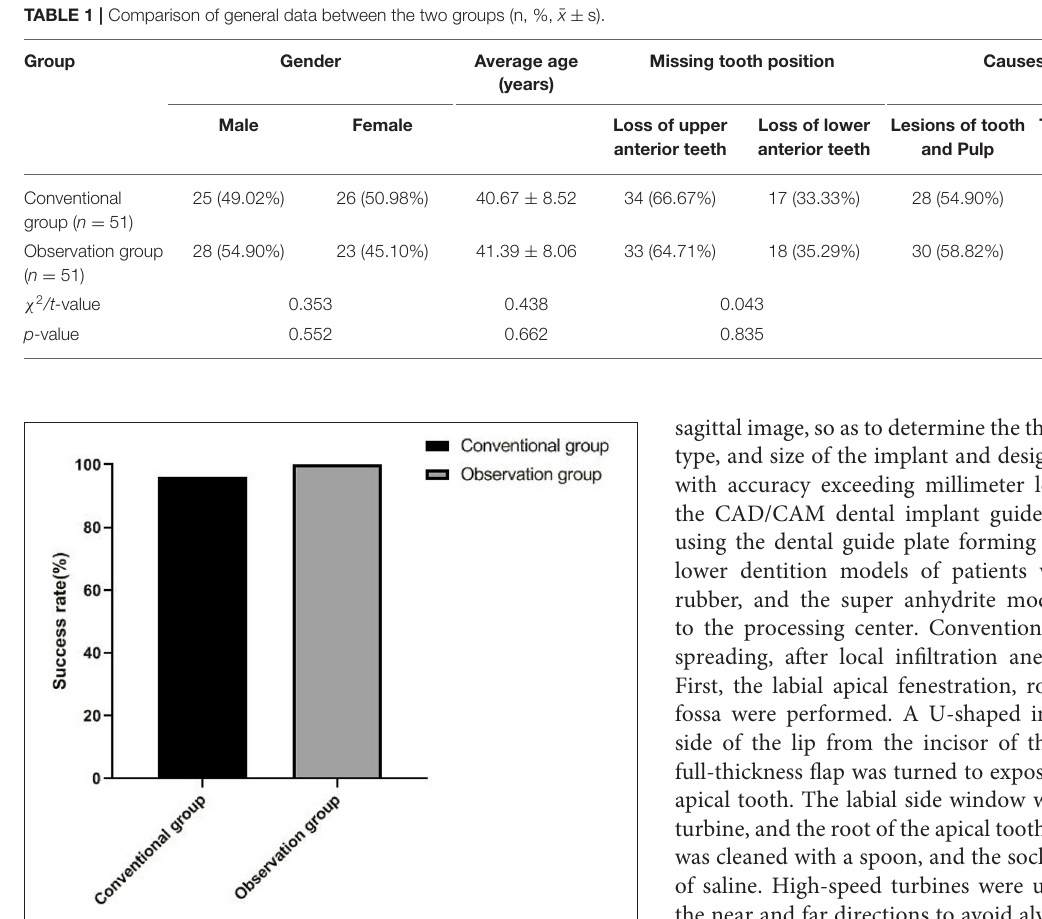
FIGURE 1 | Comparison of clinical efficacy between two groups.